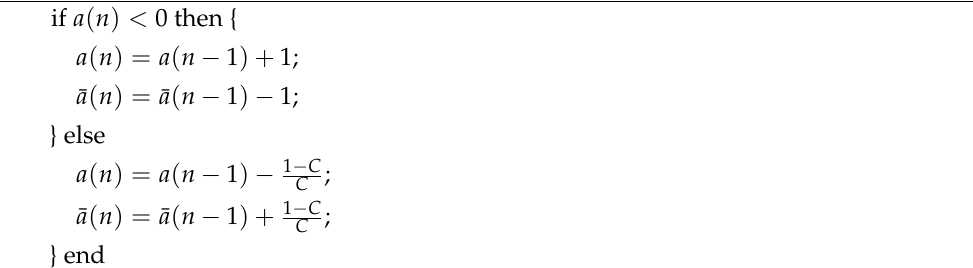
Algorithm 1: Algorithm for computing the weighting